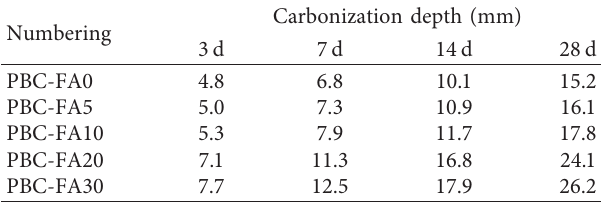
Table 2: Average carbonization depth.